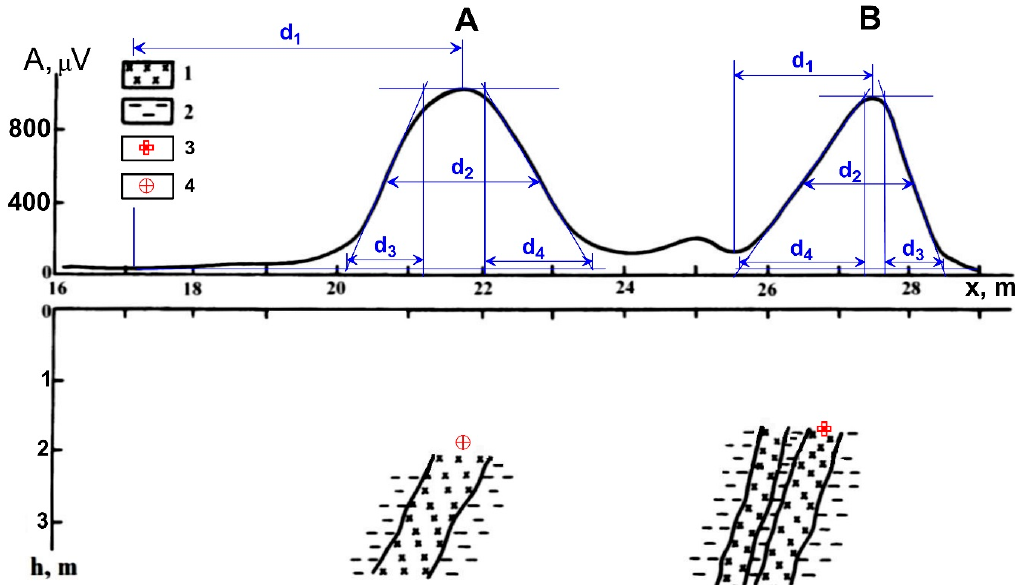
Figure 5. Quantitative analysis of piezoelectric anomaly in the crystal-quartz deposit Pilengichey of the Subpolar Ural (Russia) (initial geological-geophysical data from [30]. (1) ore-quartz zone; (2) host rocks, siltstone; results of quantitative examination ((3) and (4)): (3) position of the center of HCC inscribed to the upper part of the anomalous body; and (4) position of the center of upper edge of a thin bed.